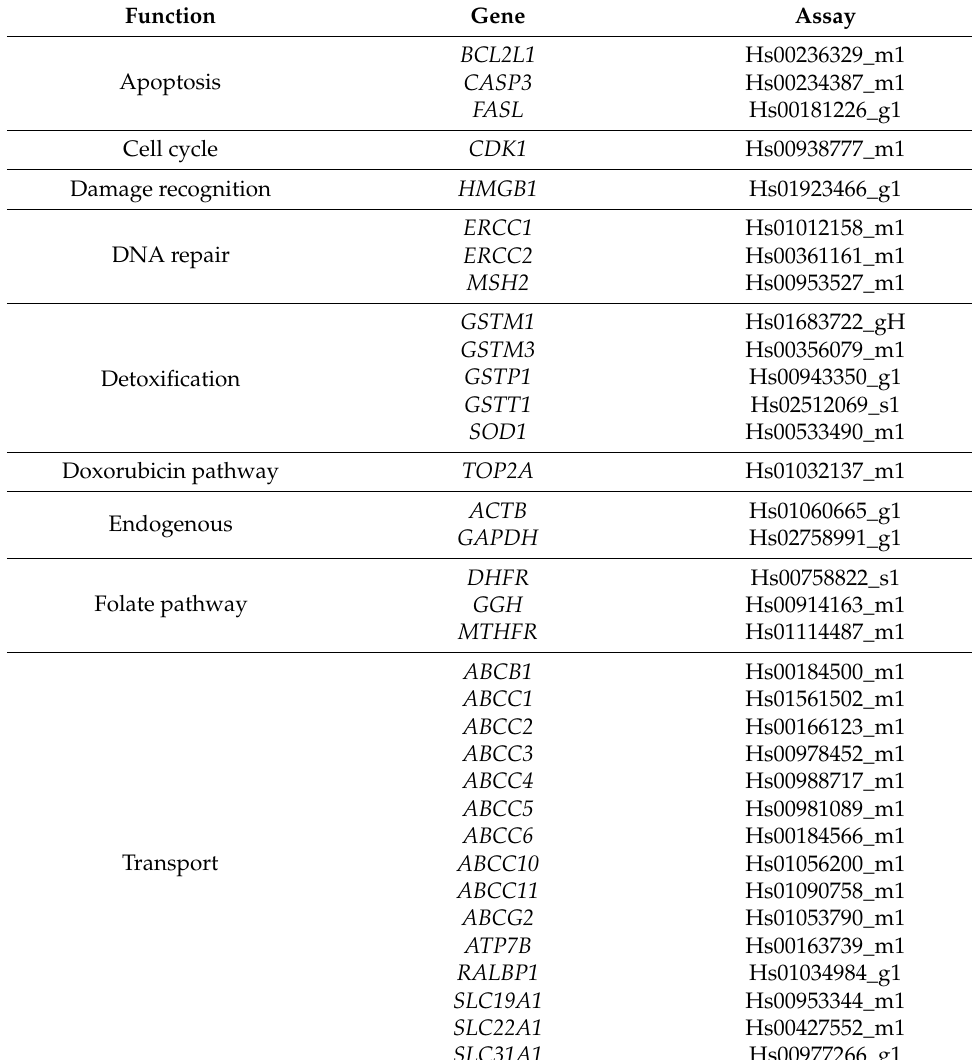
Table 3. TaqMan ® Gene Expression